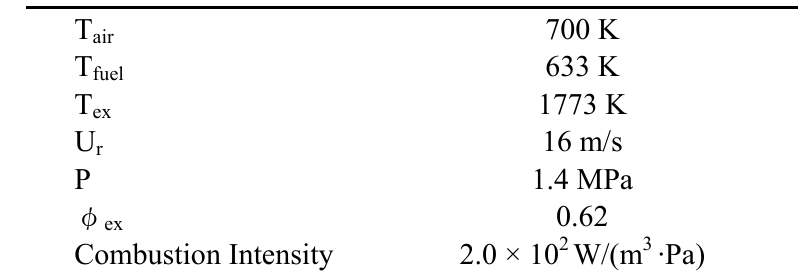
Table 5. Standard test conditions.